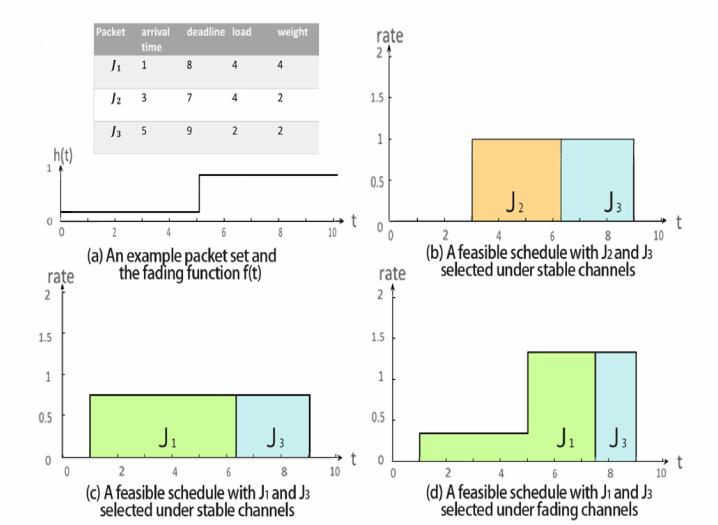
Figure 1. An example with three packets. The table in ( a ) shows the detailed information of the three packets and the step function in ( a ) shows the fading factors over time. ( b – d ) are possible rate scheduling policies under static and fading